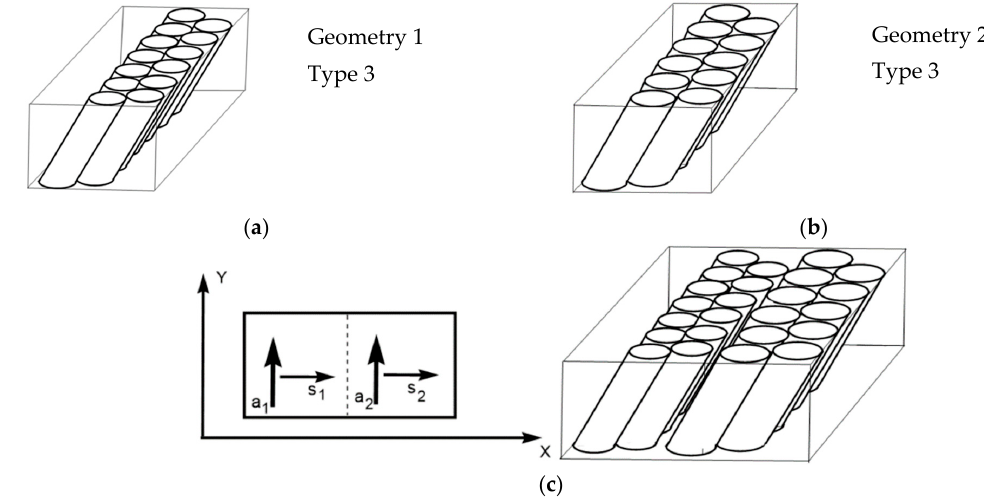
Figure 11. Combination of a pair of sections: ( a ) Section of Type 3 for Geometry 1; ( b ) Section of Type 3 for Geometry 2; ( c ) Combination of these two sections according to Variant 8.